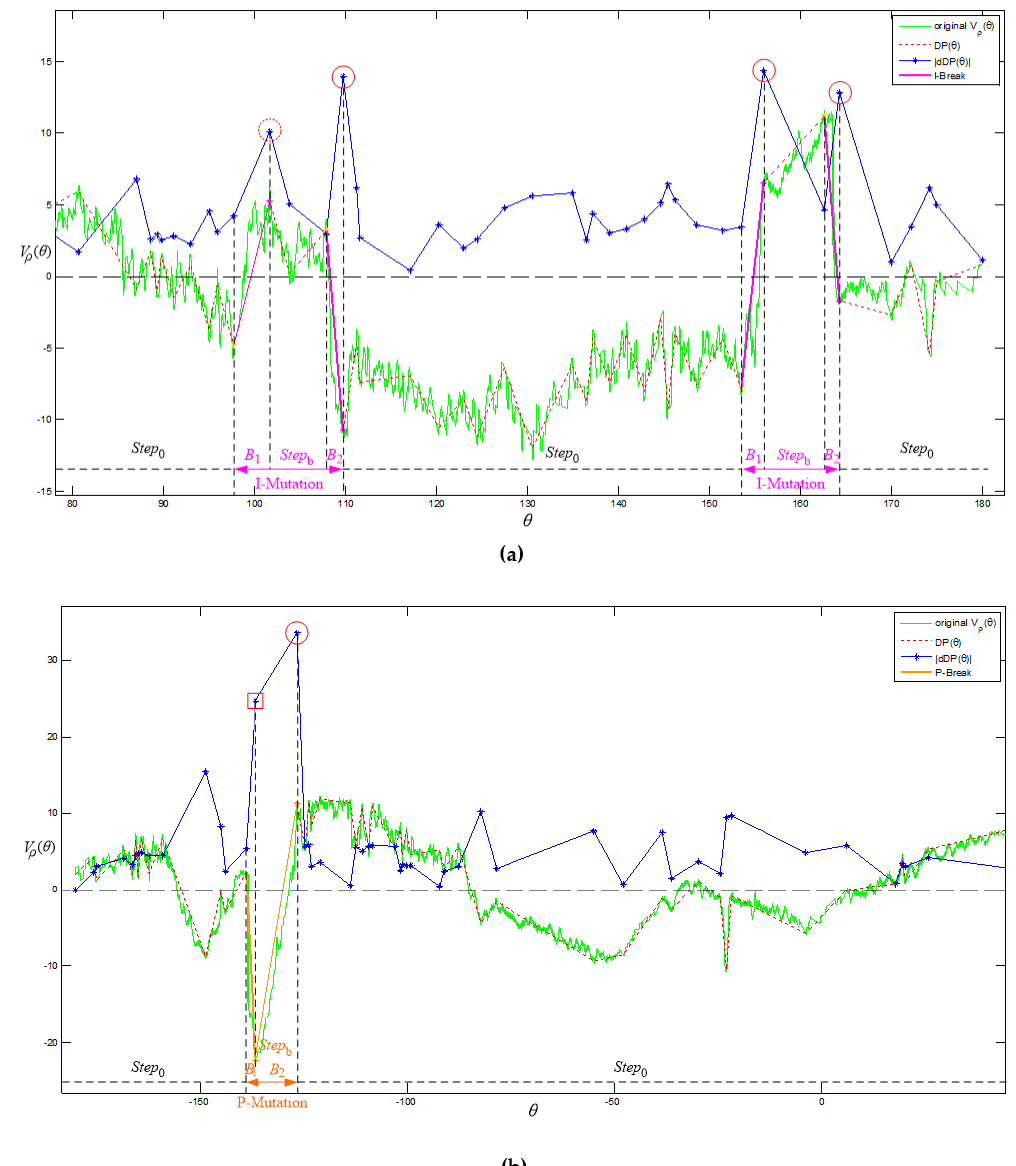
Figure 7. Breaks detection and mutation grouping, in which horizontal axis is polar angle θ , vertical axis is radial distance to the fitted circle, green solid line denotes original V ρ ( θ ) sequence, red dashed line denotes the simplified DP ( θ ) sequence, blue line is the absolute di ff erence of DP ( θ ) , and the segments divided by break groups are labeled. ( a ) I-Break in magenta lines with detected major peaks in circles; ( b ) P-Break in orange lines with a detected major peak in